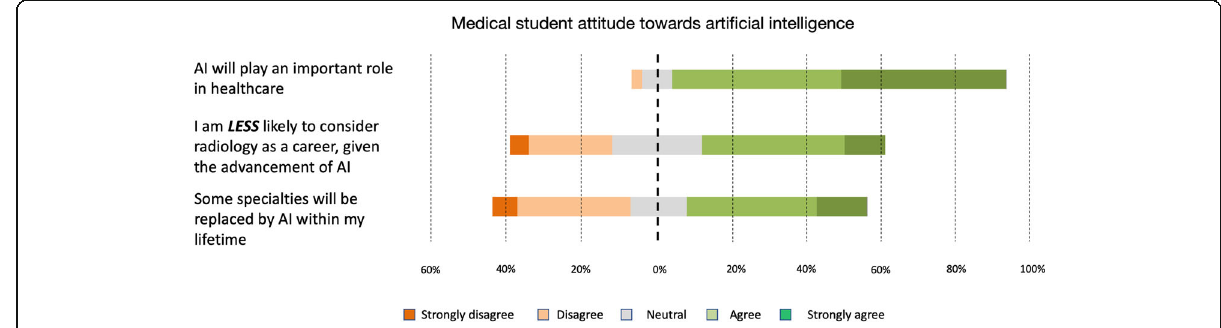
Fig. 1 Summary of questions relating to medical student attitude towards